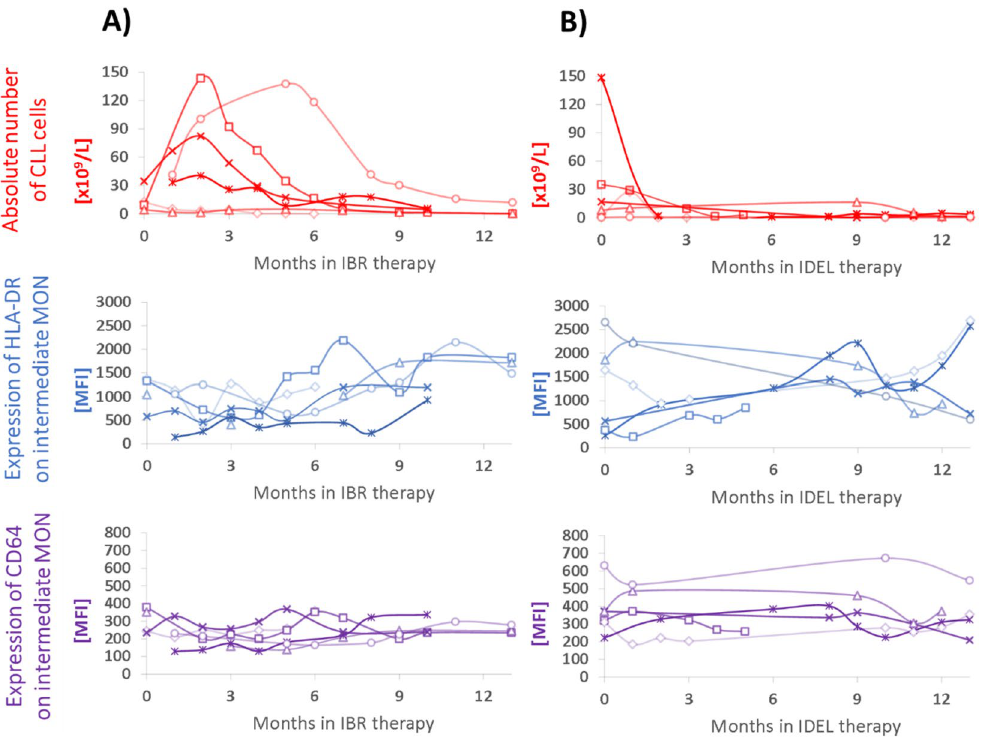
Figure 5. Time-dependent changes of CLL counts and expression of HLA-DR and CD64 on intermediate monocytes in CLL patients treated with ( A ) ibrutinib (IBR, n = 6) and ( B ) idelalisib (IDEL, n = 6). CLL cell count is shown using red dots and curves; the expression of HLA-DR and CD64 on intermediate monocytes using blue and violet graphs, respectively. Not all patients were sampled for each time point.